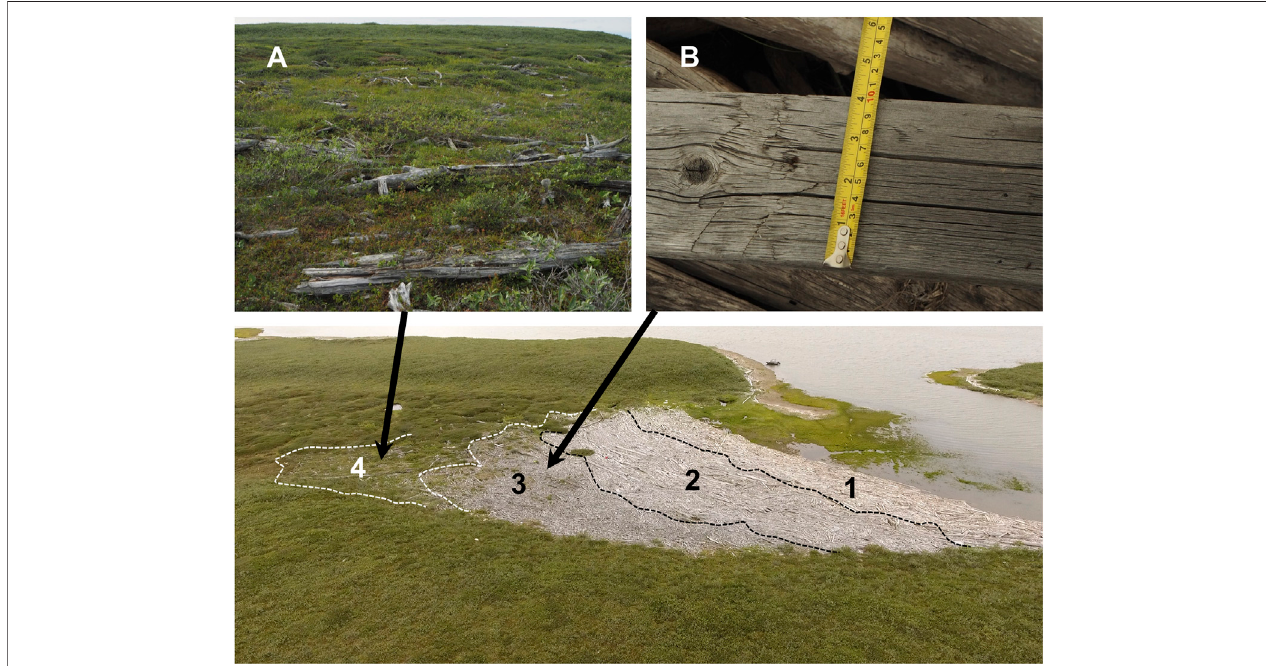
FIGURE 6 | The layers of differing ages of wood and anthropogenic debris at the Tuktoyaktuk Harbor site are visible from the air. The youngest material fronts the pile (1), whereas the second portion consists of large amounts of lumber and plywood with limited amounts of plastic items (2). Above this is the third layer with homogenously similar weathered wood and contains the rare true dimensional lumber pieces (3 and upper right photo (B) ). The upper most location consists of only sparsely distributed heavily weathered driftwood that is embedded into the tundra surface (4 and upper left photo (A) ).